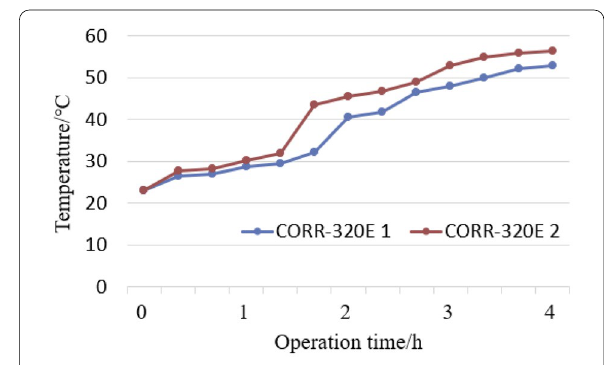
Figure 17 Prototype of the reducer